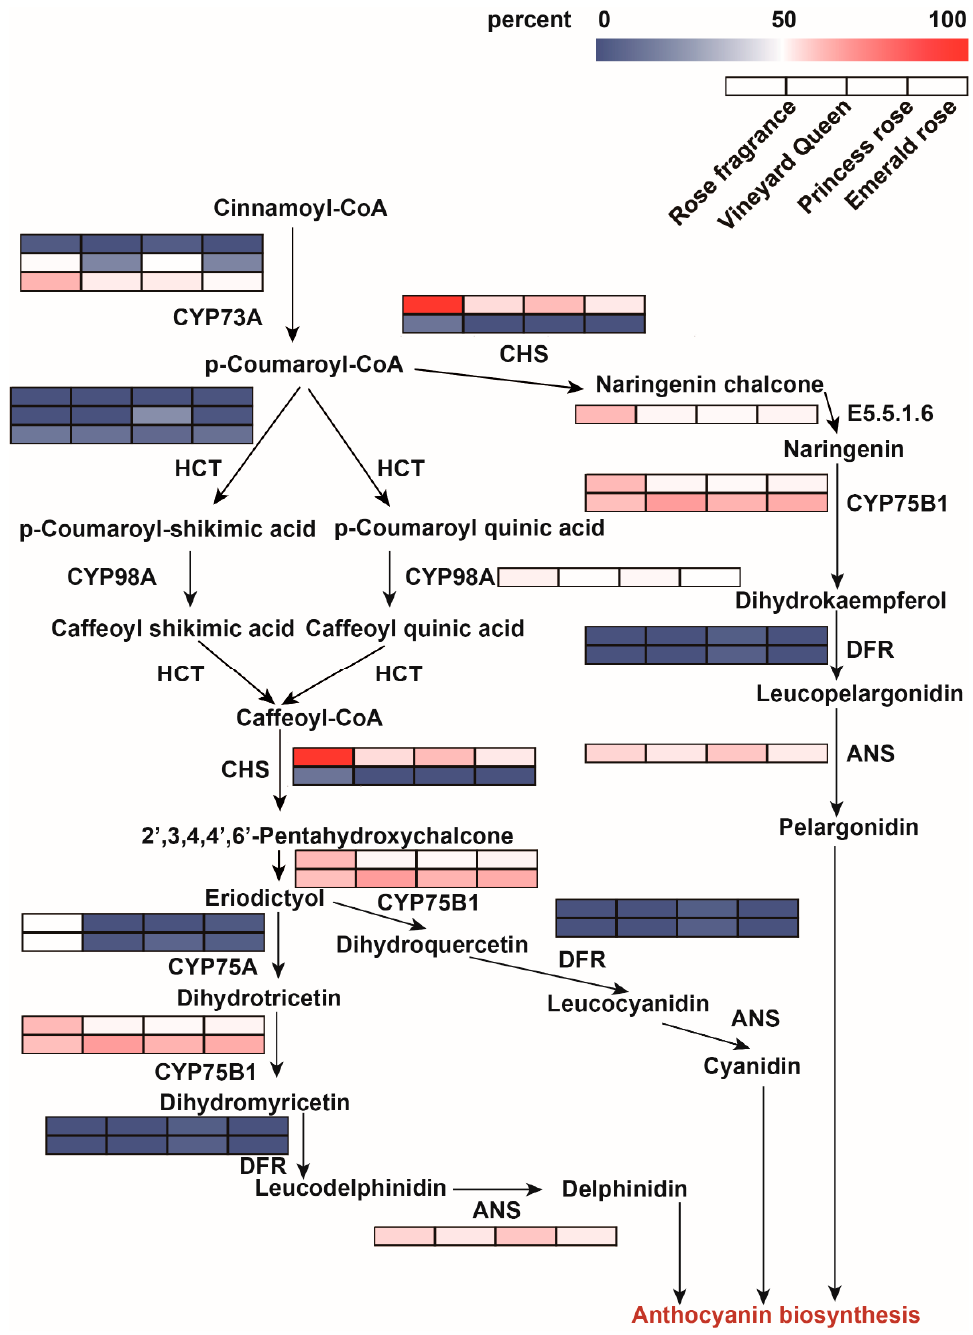
Figure 3. Expression trends and screening of enzyme genes in flavonoid synthesis pathway. Darker color represents higher expression. Heat maps show, from left to right, expressions of ‘Rose fragrance’, ‘Vineyard Queen’, ‘Princess rose’, and ‘Emerald rose’. Different rows represent homologous genes of genes.